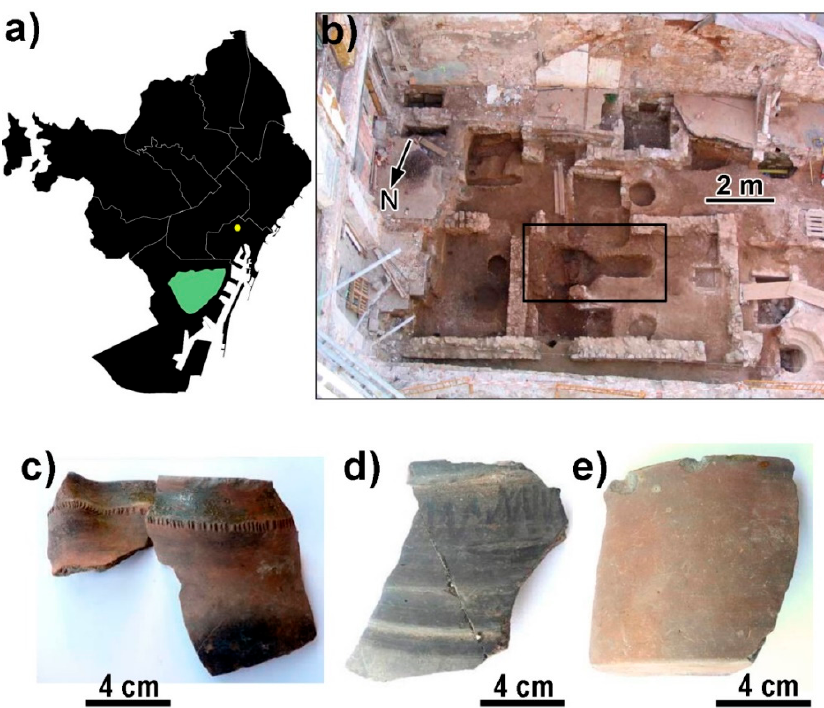
Figure 8. ( a ) Location of the Montjuïc hill (green) and the excavated workshop (yellow dot) within the Barcelona municipality. ( b ) Archaeological remains of the pottery production of the kiln. ( c – e ) Examples of the pottery production of the kiln: ( c ) Glazed jug, ( d ) pot, ( e ) serving pot .